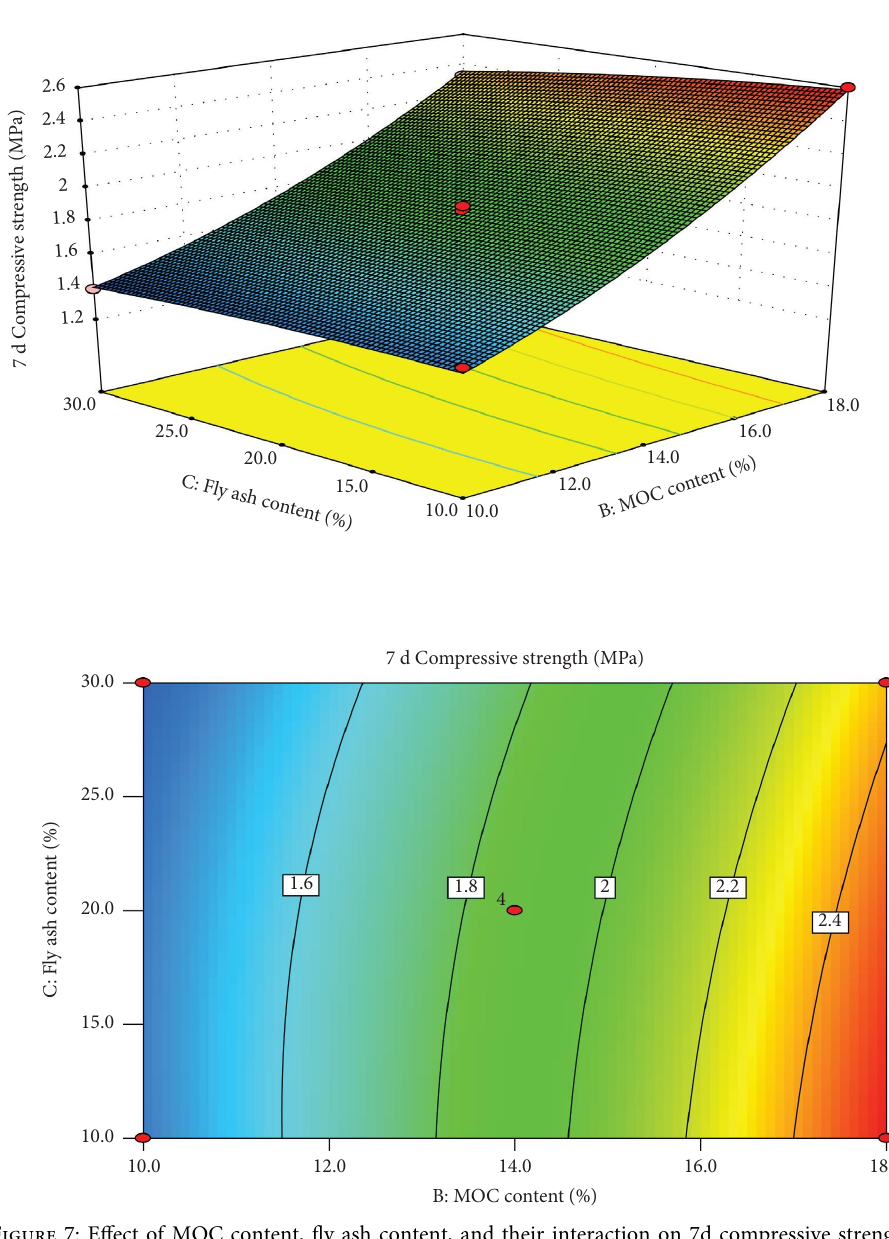
Figure 7: Efect of MOC content, fy ash content, and their interaction on 7d compressive